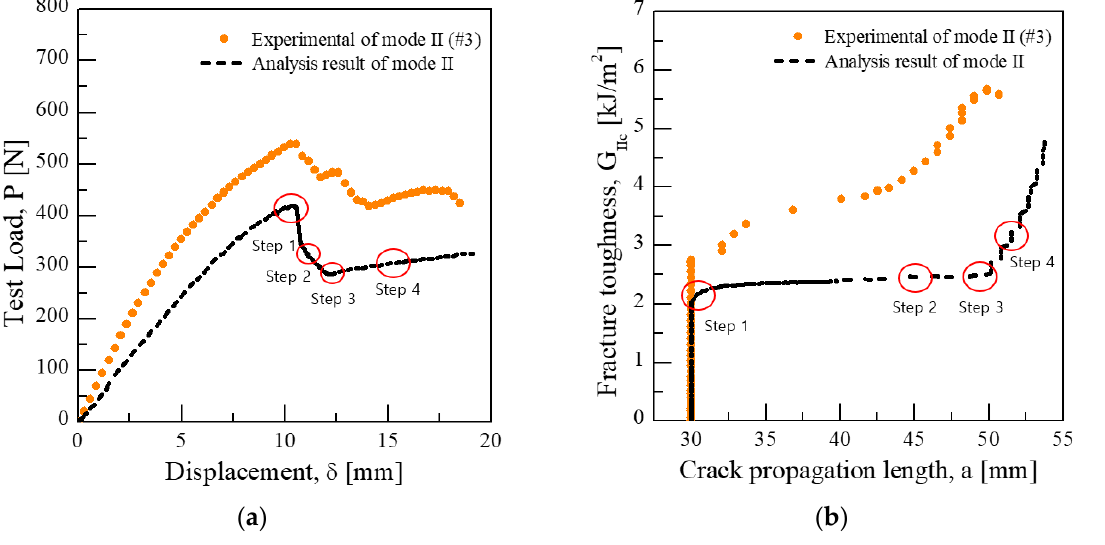
Figure 14. Comparative analysis of specimen-level FE analysis results and Mode II test results: analysis result shape of Mode I: ( a ) P − δ curve and ( b ) G II − a curve.